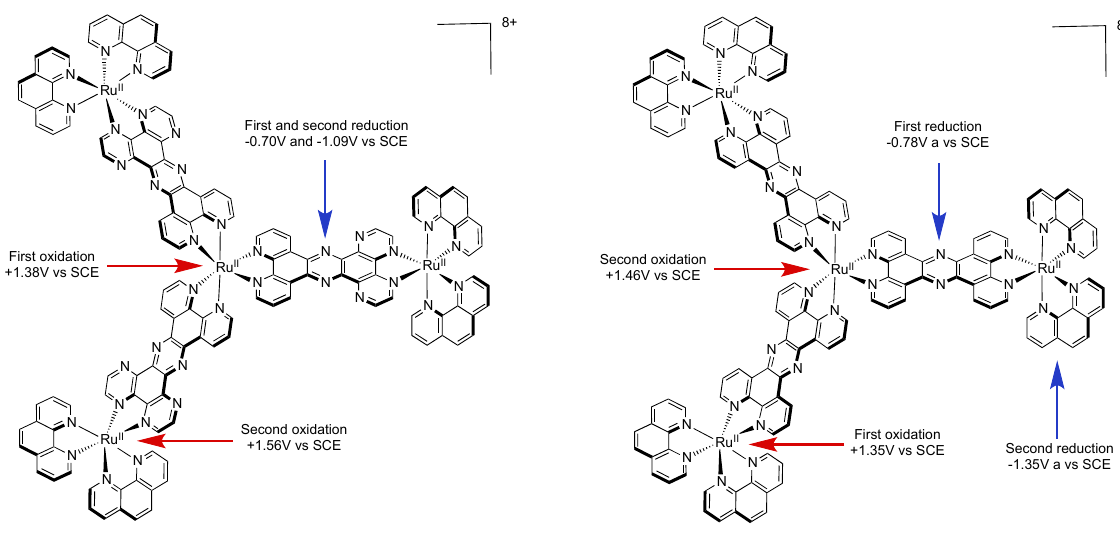
Figure 44. Schematic representation of the oxidation and reduction processes in PHEHAT and TPPHZ tetranuclear complexes.